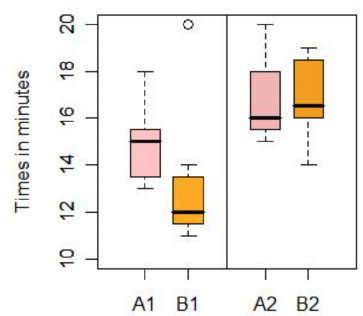
Figure 14. Boxplot showing the distribution of times to solve the two tasks by each group.